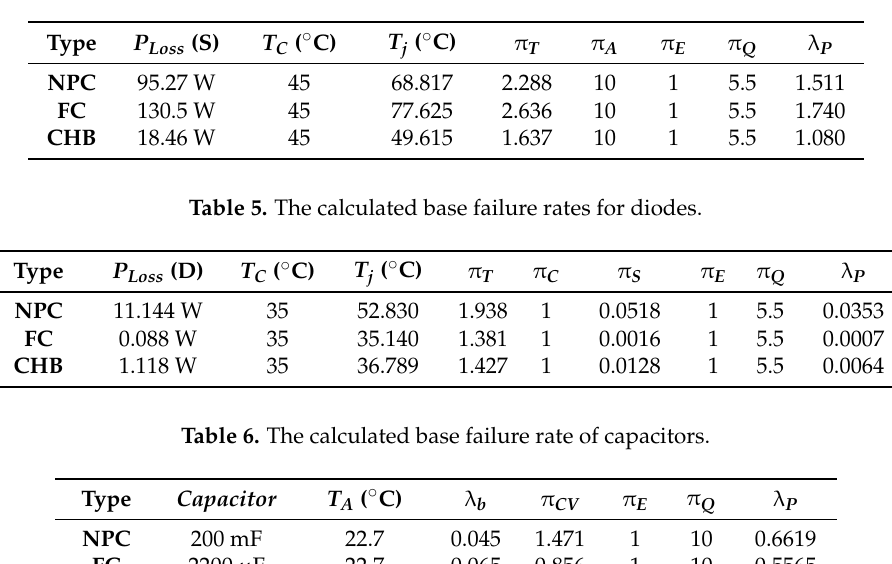
Table 4. The calculated base failure rates for switches.